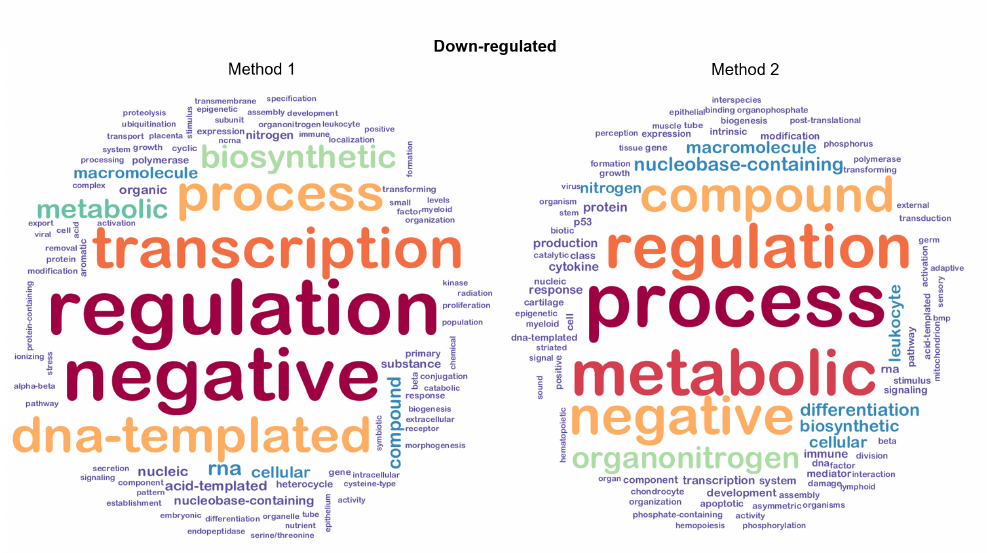
Figure 10. Word clouds for GO terms related to down-regulated genes. The word clouds show the top 100 words retrieved using the procedure described in items 1–4 in Section 2.5.2. Both single word size and colour depend on word